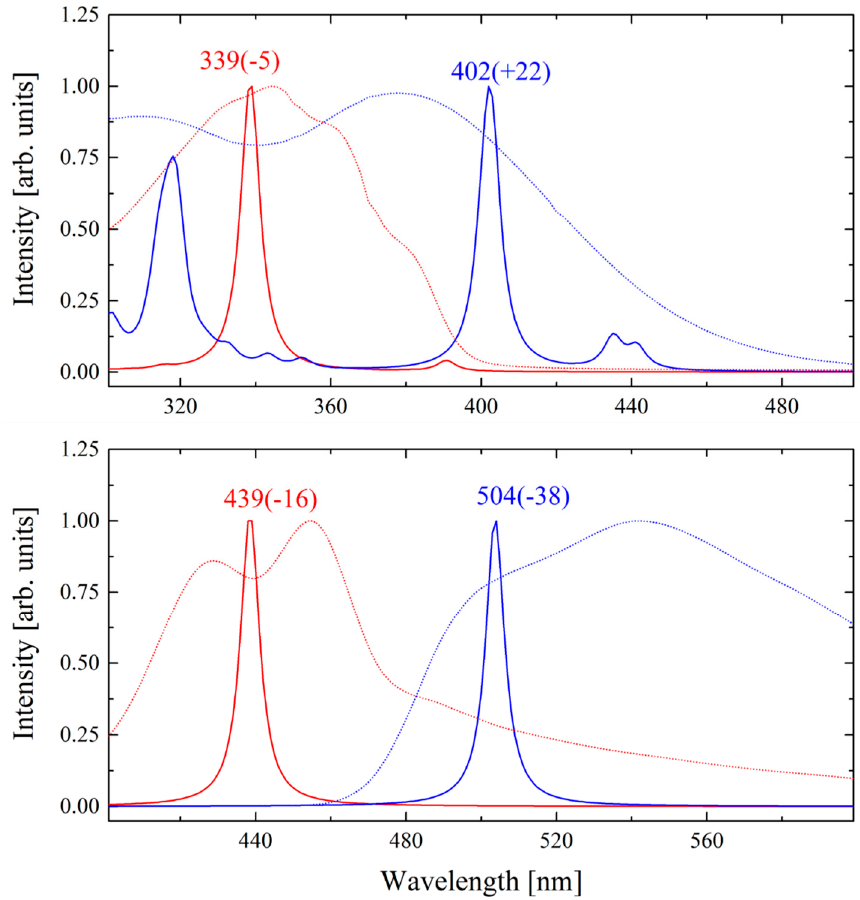
Figure 10. Absorption ( above ) and fluorescence ( below ) spectra of Ac1 (red lines) and Ac2 (blue lines). Calculated data and experimental values are represented by solid and dotted lines, respectively. Simulated excitations were convoluted adopting a Lorentzian function with 6 nm of FWHM. Positions of the main simulated peaks are reported including the difference shift with the experimental values (bracket).